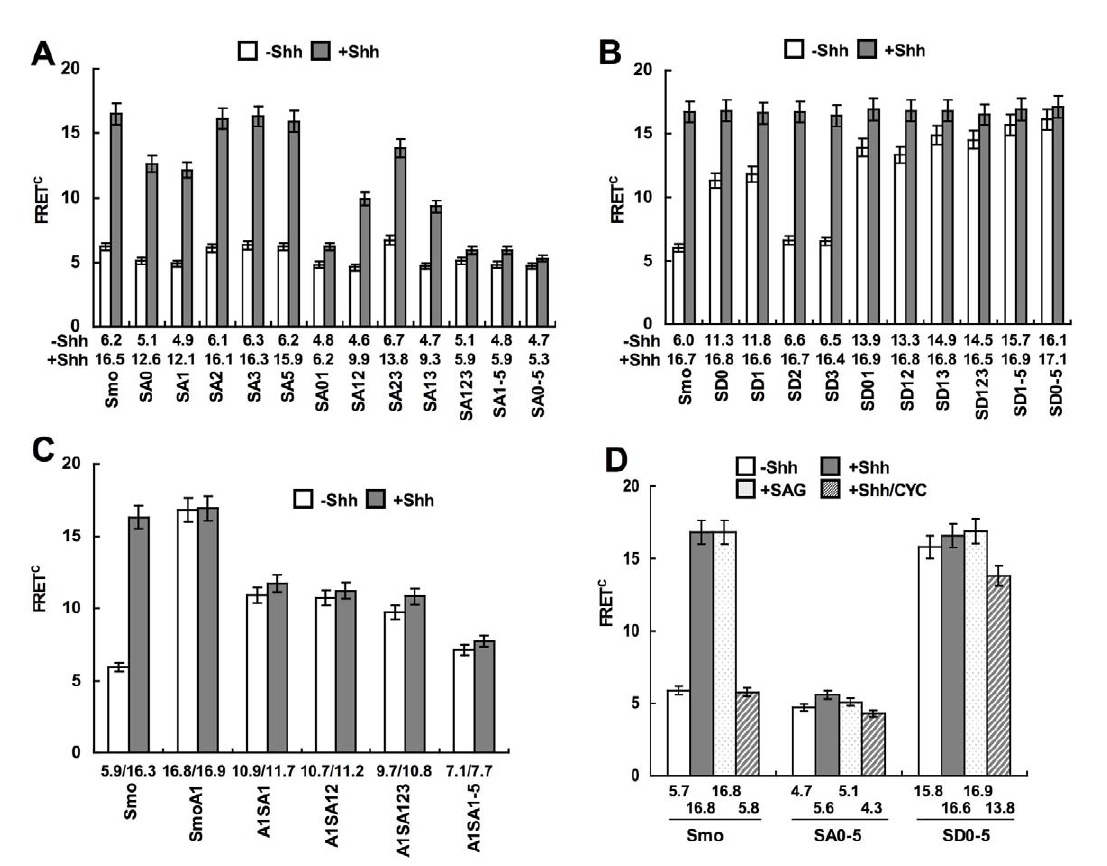
Figure 5. Shh, A1, SAG, and cyclopamine regulate Smo conformation through CK1/GRK-mediated phosphorylation. (A–C) FRET analyses of NIH 3T3 cells transfected with C-terminally CFP/YFP-tagged wild type Smo or Smo variants with the indicated mutations and treated with or without Shh-conditioned medium (mean 6 s.d., n $ 10). (D) FRET analysis in NIH 3T3 cells transfected with Smo-CFP C /YFP C , SmoSA0–5-CFP C /YFP C , or SmoSD0–5-CFP C /YFP C , and treated without or with Shh-conditioned medium, 200 nM SAG, or a combination of Shh-conditioned medium